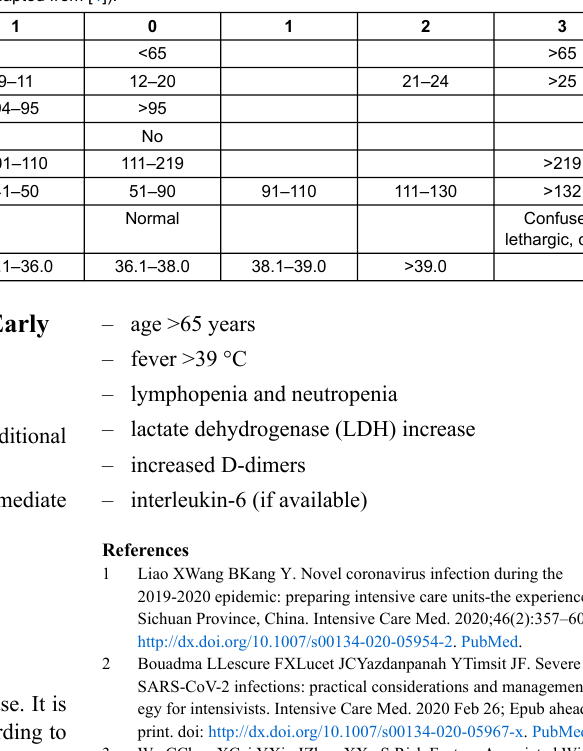
Table 1: Decision support for patient assessment using the modified Early warning score (adapted from [1]).